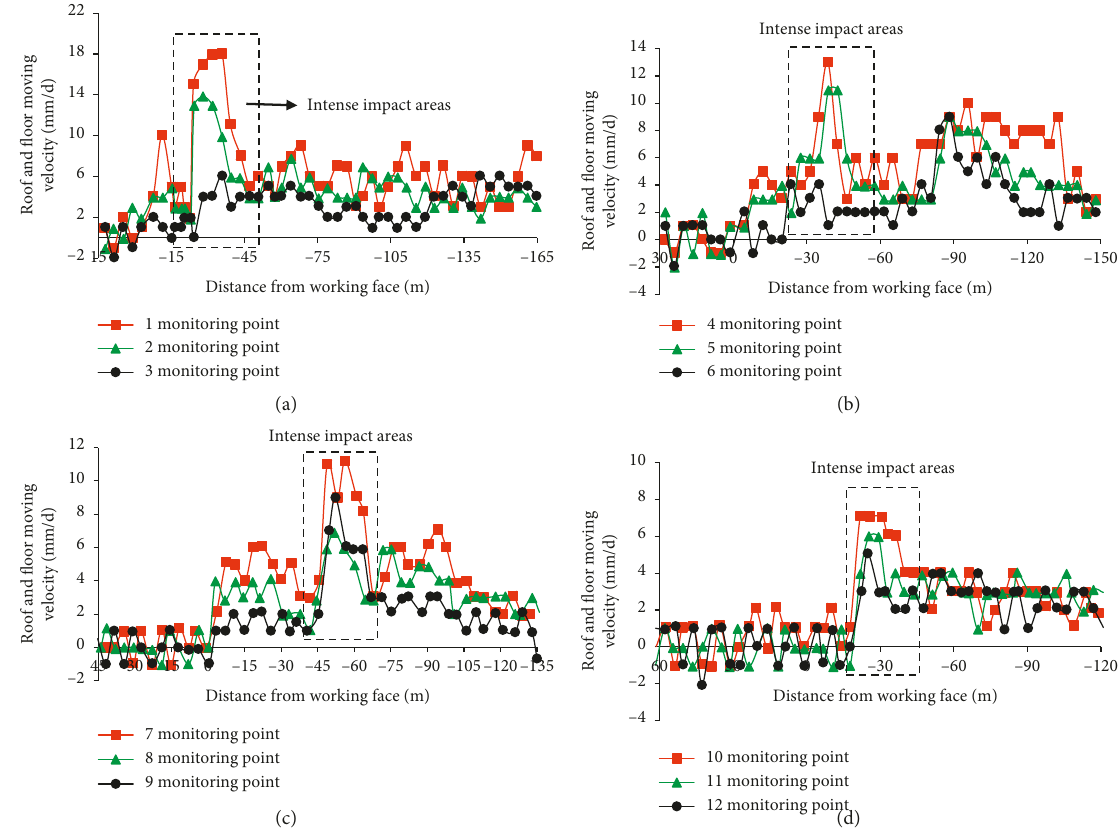
Figure 30: Roof and floor moving velocities of four monitoring stations. (a) I station. (b) II station. (c) III station. (d) IV station.